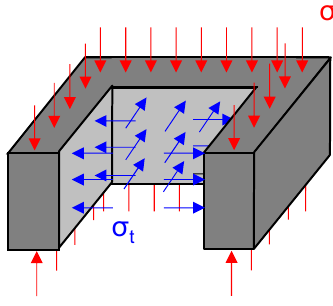
Figure 13. Schematic view of the stress state on the half part of a HPFRC elementary block of the specimen S1.